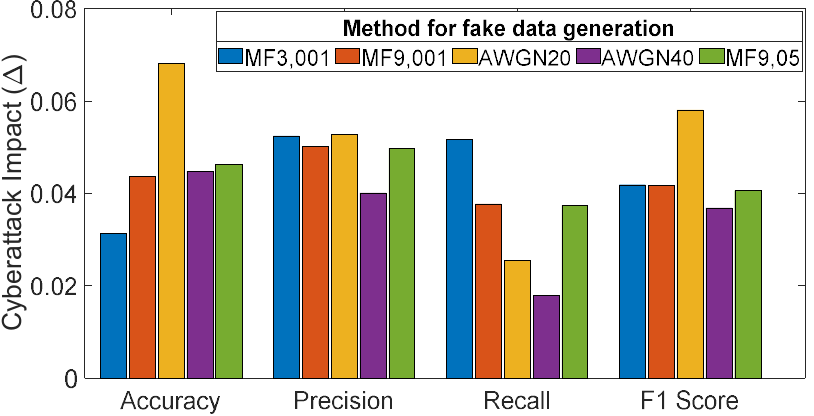
Figure 3. Metric reduction versus BCI performance metrics for each cyberattack method.